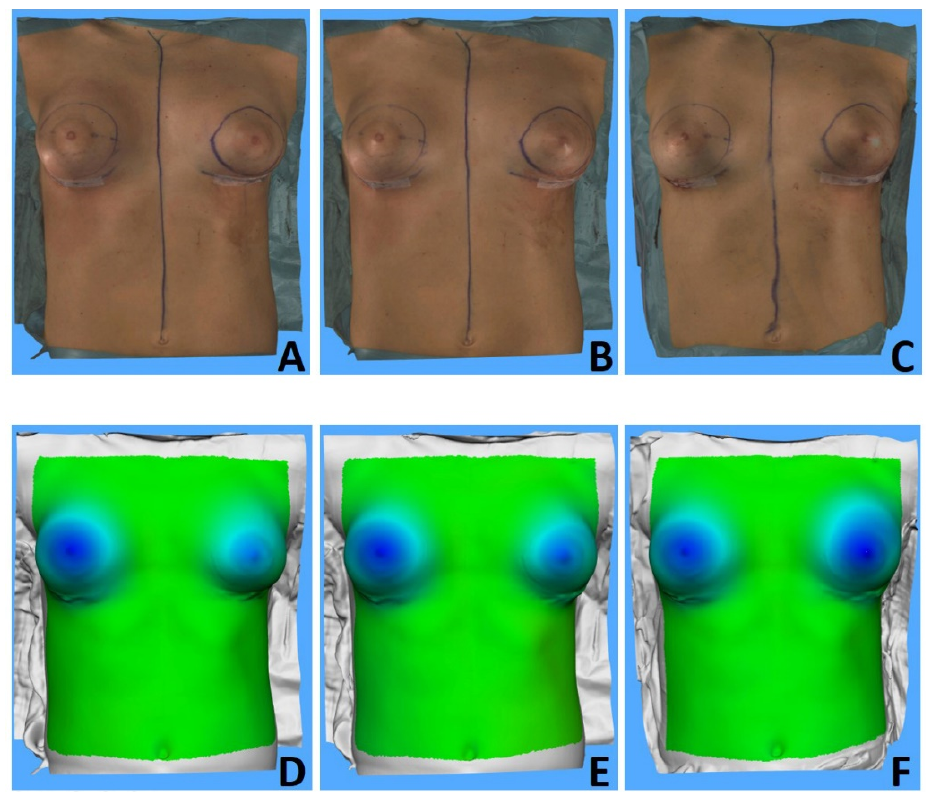
Figure 3. Intraoperative 3DSI frontal views ( A – C ) and surface-to-surface analysis ( D – F ) of three different sizers placed in the left breast of a 20-year-old patient in comparison to the preoperative image: a 140 cc anatomical low-height moderate-plus sizer ( left row ), a 170 cc anatomical low-height moderate-plus sizer ( middle row ) and a 225 cc round moderate-plus sizer ( right row ). A 195 cc anatomical low-height moderate-plus sizer was placed in the right breast.